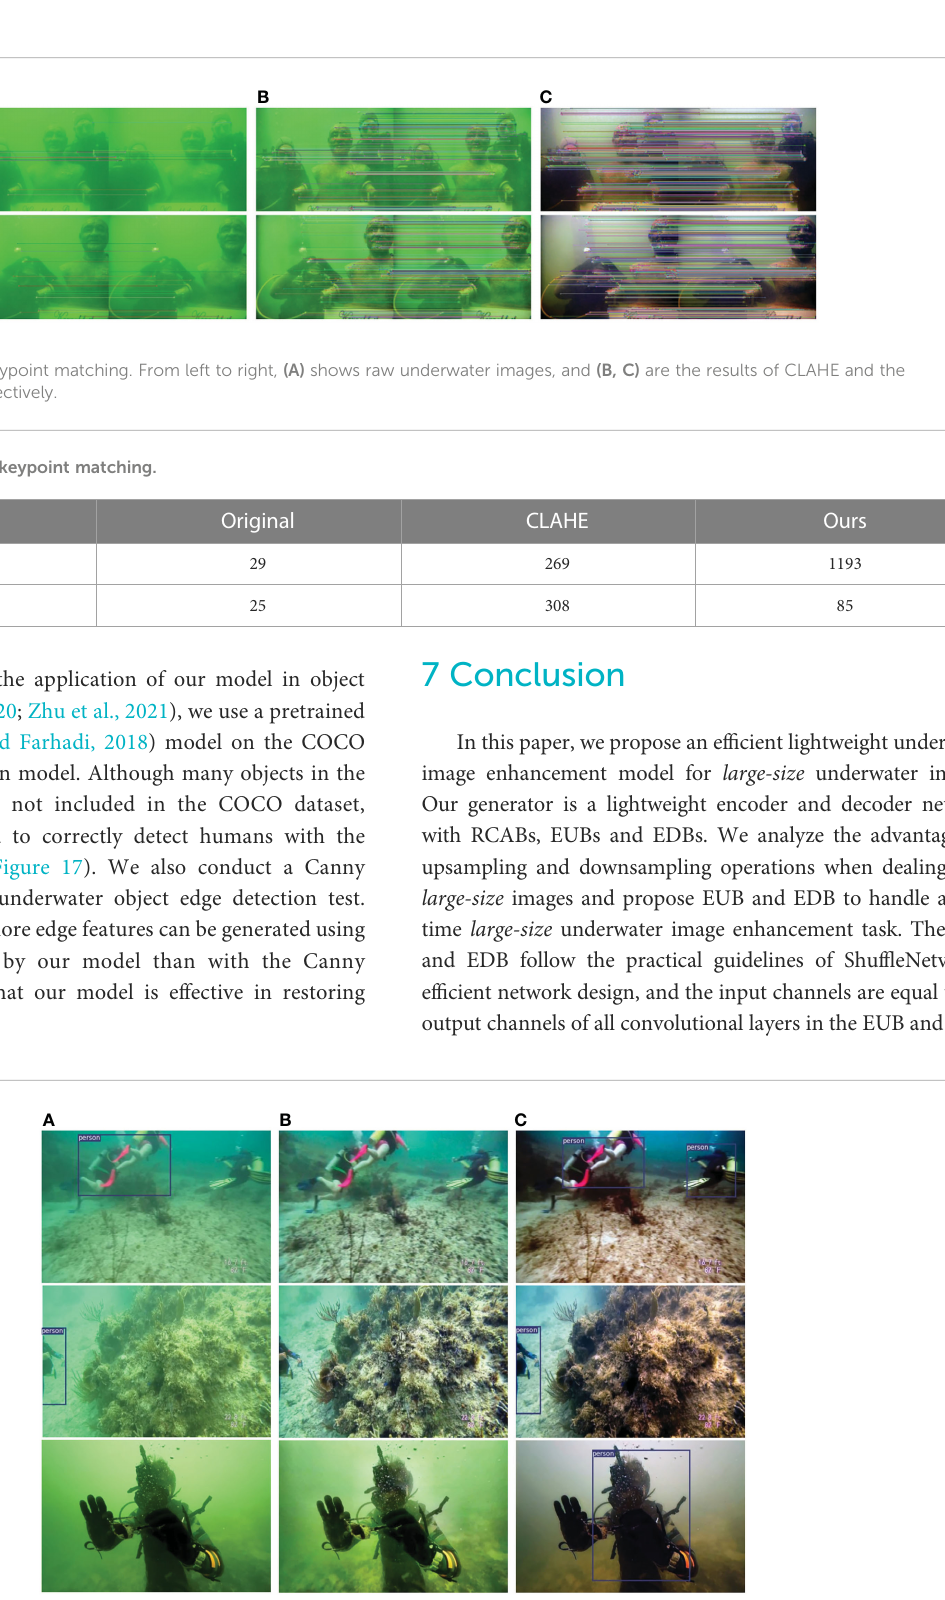
FIGURE 17 Visual results of object detection. From left to right, (A) shows the raw underwater images, and (B, C) are the results of CLAHE and the proposed model, respectively.